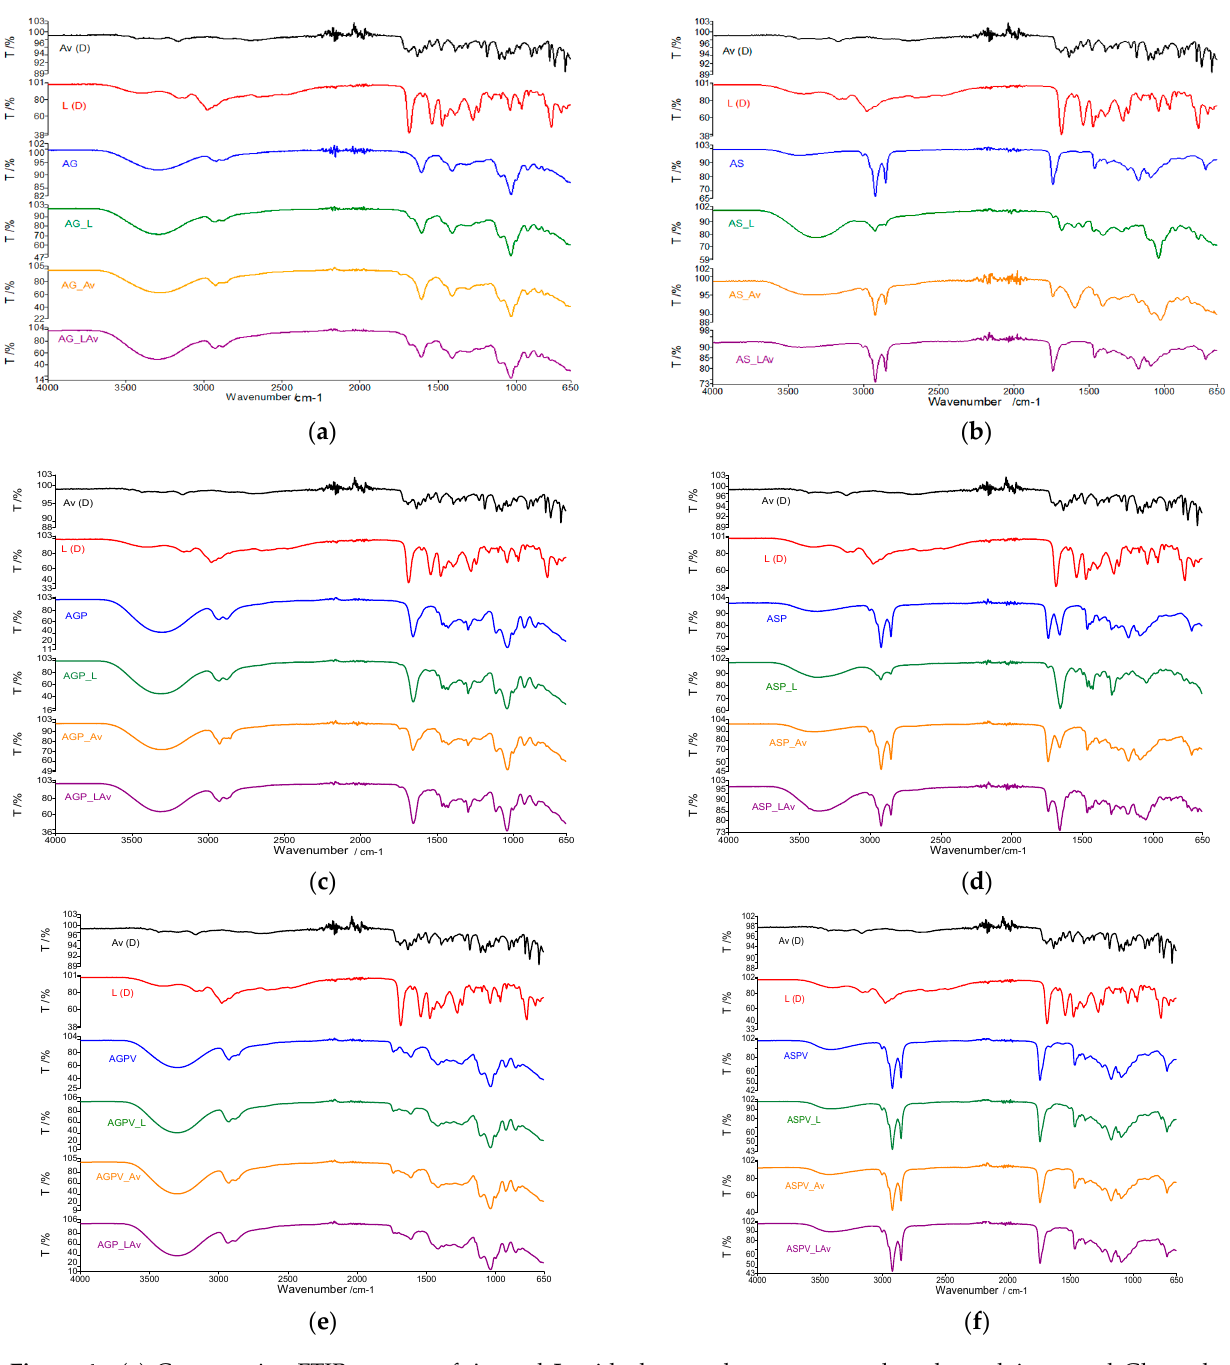
Figure 4. ( a ) Comparative FTIR spectra of Av and L with the membranes spectra based on alginate and Glycerol; ( b ) Comparative FTIR spectra of Av and L with the membranes spectra based on alginate and Span; ( c ) Comparative FTIR spectra of Av and L with the membranes spectra based on alginate, Gly and PVP; ( d ) Comparative FTIR spectra of Av and L with the membranes spectra based on alginate, Span and PVP; ( e ) Comparative FTIR spectra of Av and L with the membranes spectra based on alginate, Gly and PVA; ( f ) Comparative FTIR spectra of Av and L with the membranes spectra based on alginate, Span and PVA.